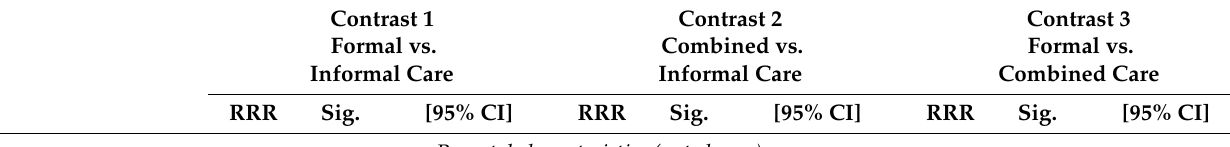
Contrast 3 Formal vs. Combined